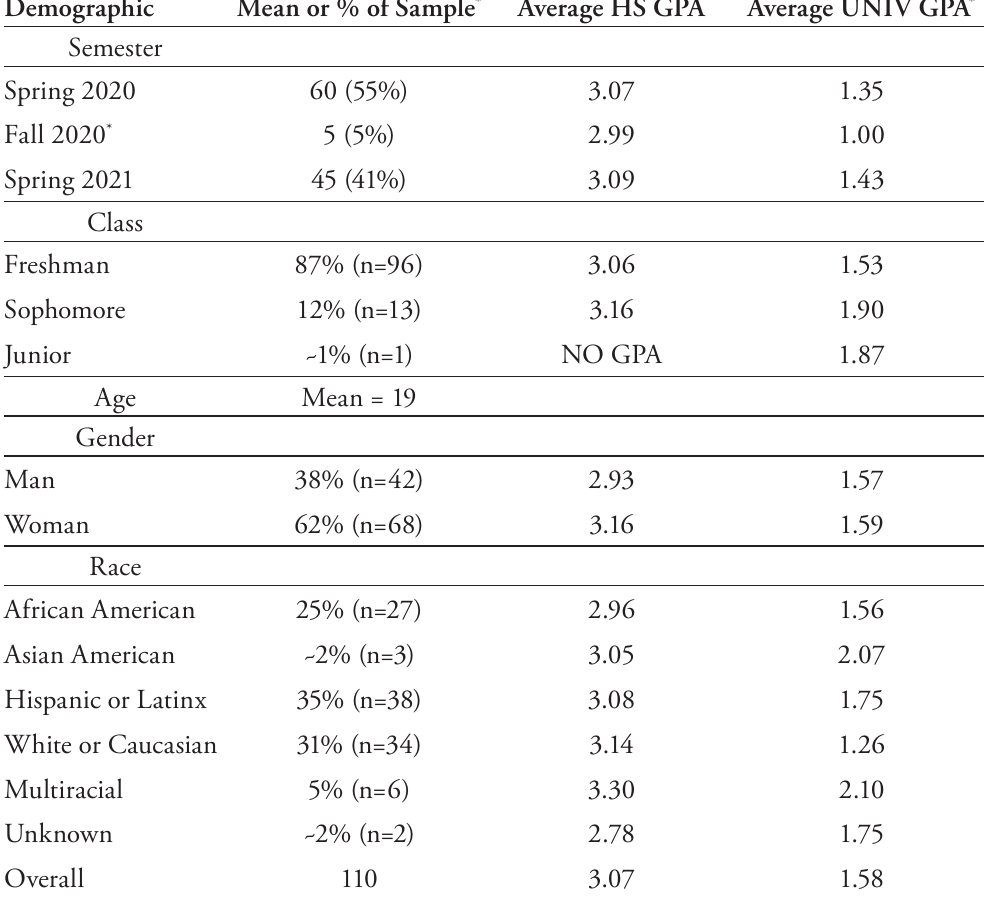
Table 1. Descriptive Statistics of Participating